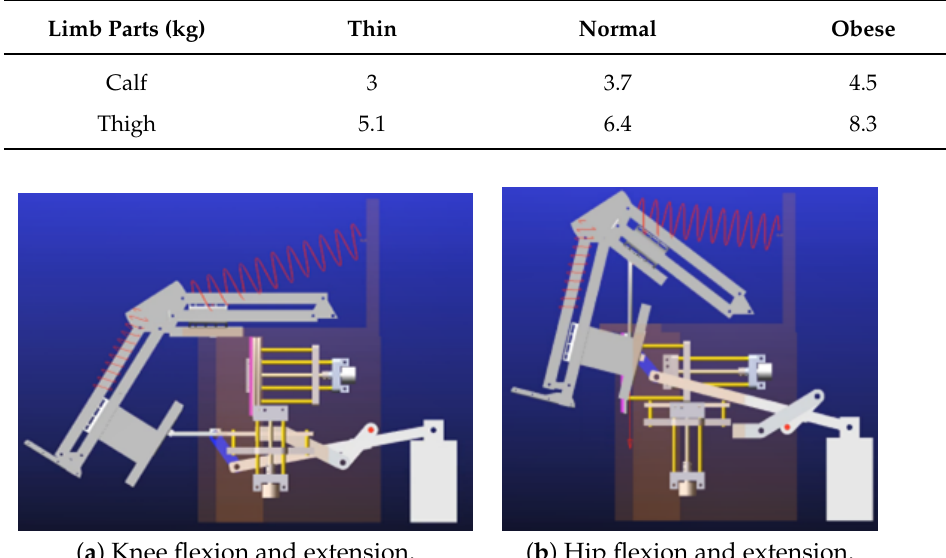
Figure 8. Knee and hip joint simulation